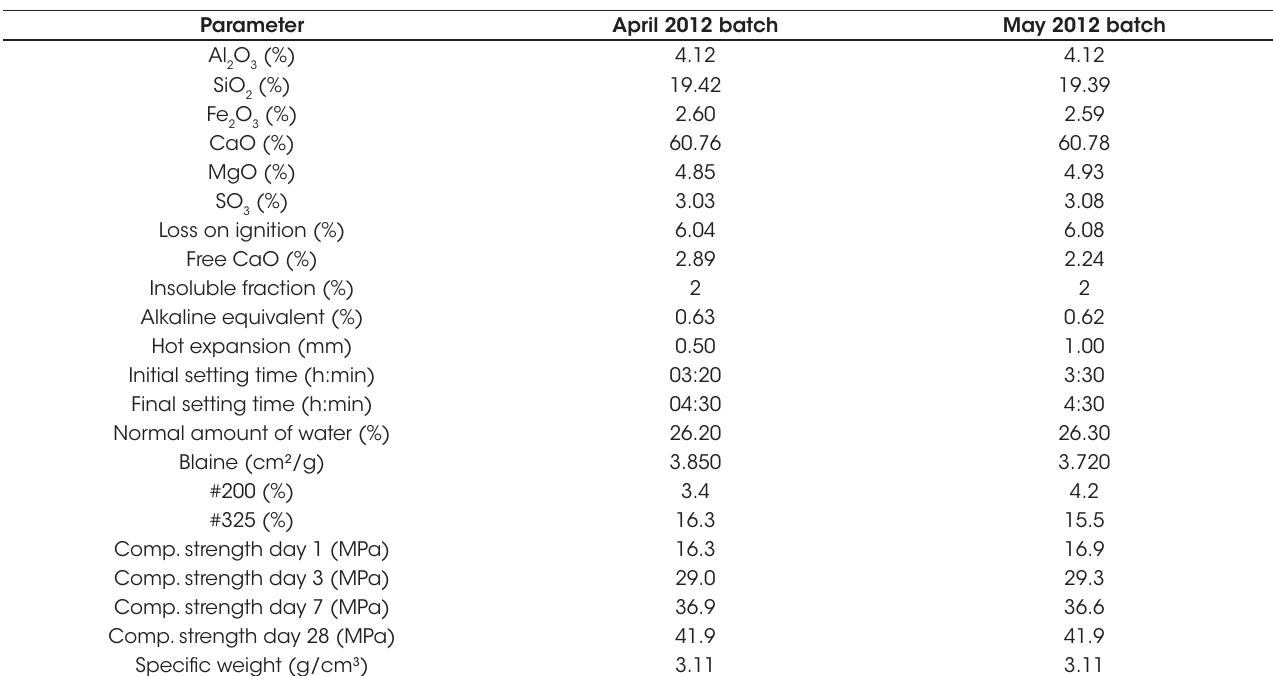
Chemical, physical, and mechanical characterization of the cement used Parameter